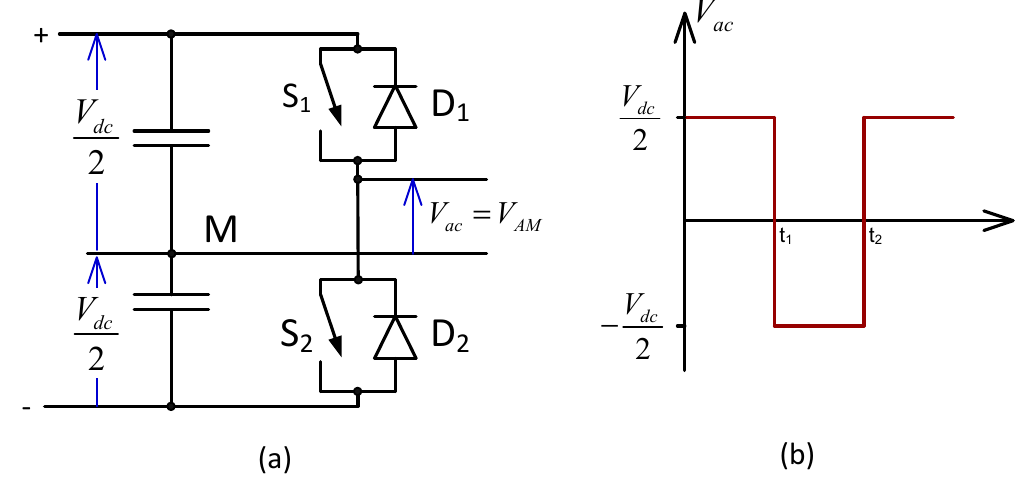
Figure 16. Basics of VSC: ( a ) One arm of the VSC; ( b ) The 2-level voltage waveform generated.